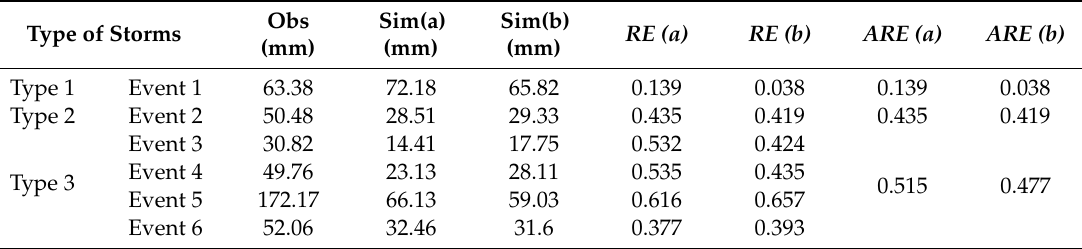
Table 6. RE values of the 24 h rainfall accumulations simulation: ( a ) Weather Research and